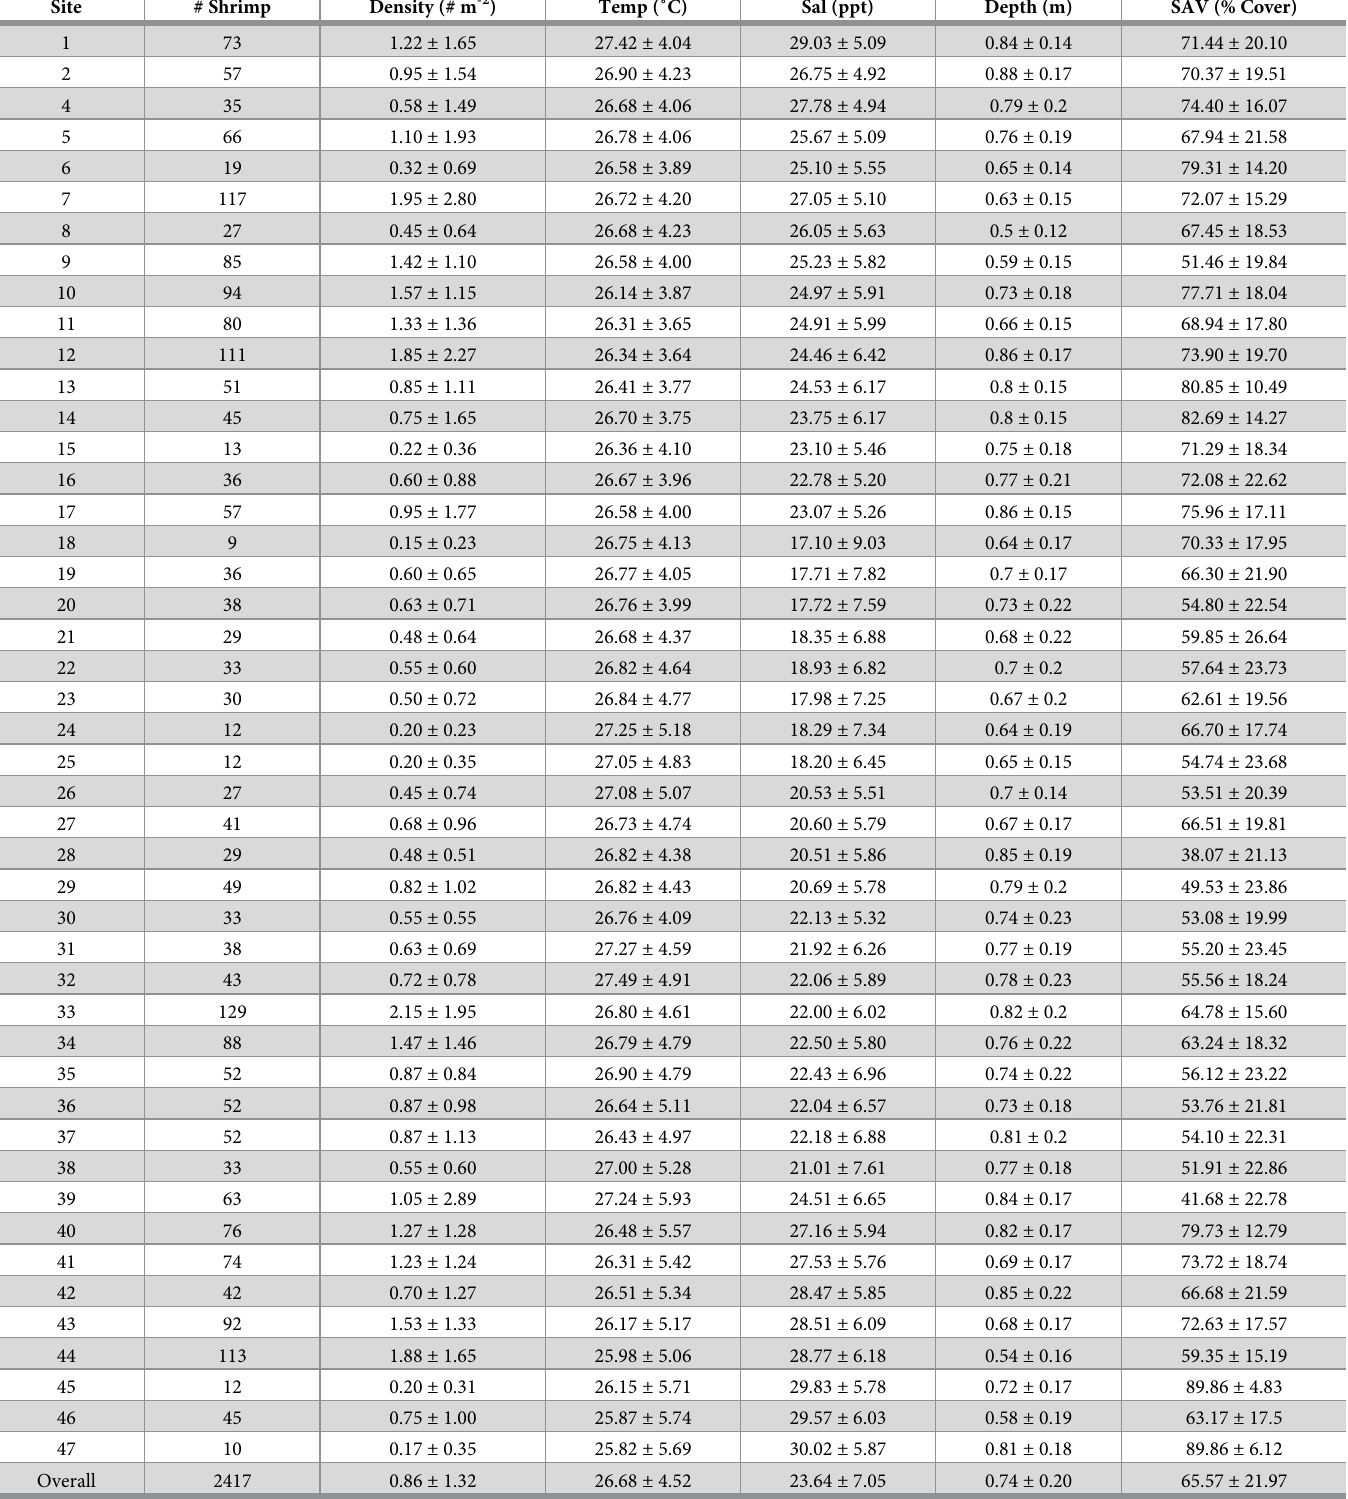
Table 2. Number of pink shrimp collected, average pink shrimp density ( ± SD), and average ( ± SD) of water quality and habitat attributes for survey sites.